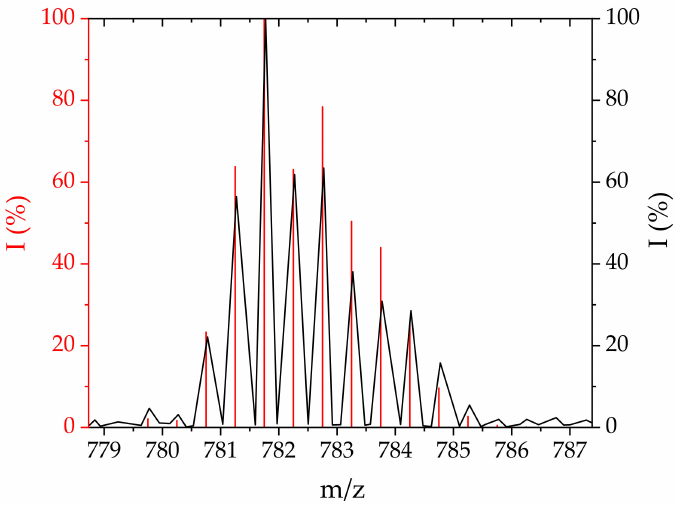
Figure 5. Mass spectra of 3 as recorded by ESI-MS in post-reaction mixture (180 ◦ C, 0.4 Bar, 4.0 L/min) (black) and simulated using The Isotope Distribution Calculator